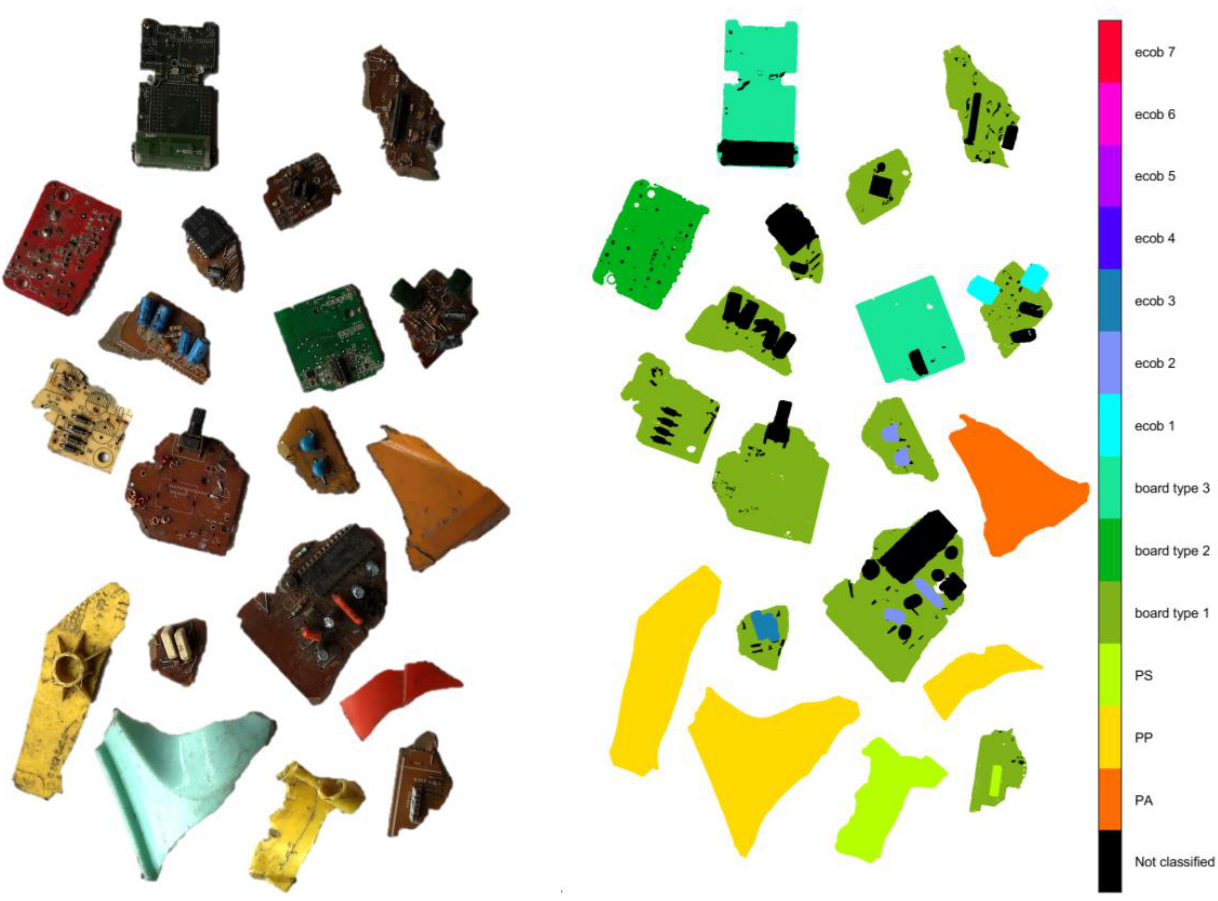
Figure 13. Result of classification for PCBs using spectral features (after step 2). Classification of three board types and four different types of components on board (PS, ecob 1, ecob 2 and ecob 3).